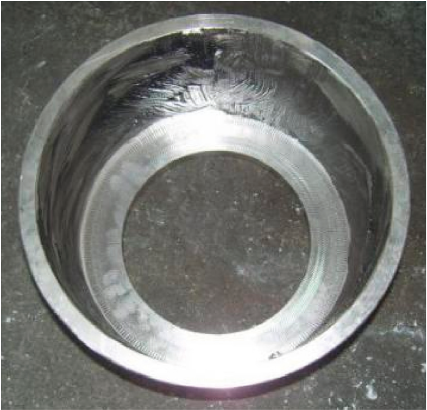
Figure 16: Test blank